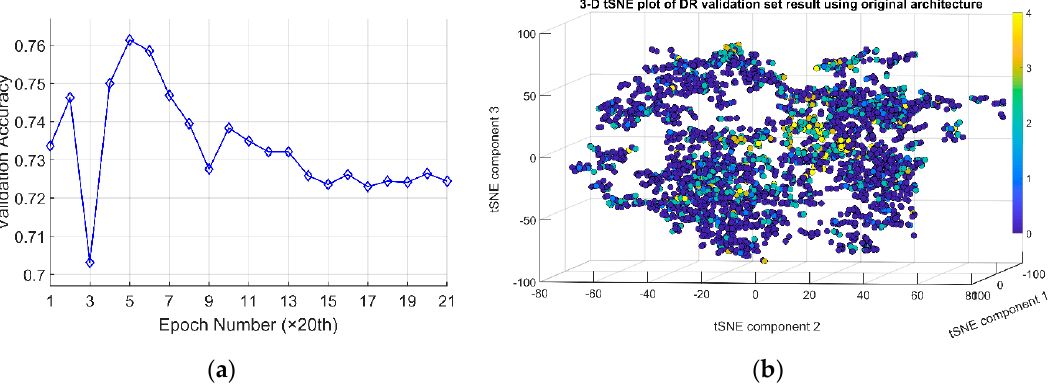
Figure 5. ( a ) validation accuracies recorded for every 20 epochs over 400 epochs. ( b ) t-SNE visualization of validation set in activation space representation by the trained CNN with feedforward structure with dual modules. The arrangement of circles of class 0 to 4 in 3-dimensional space reflects the correct sequence of disease progression.